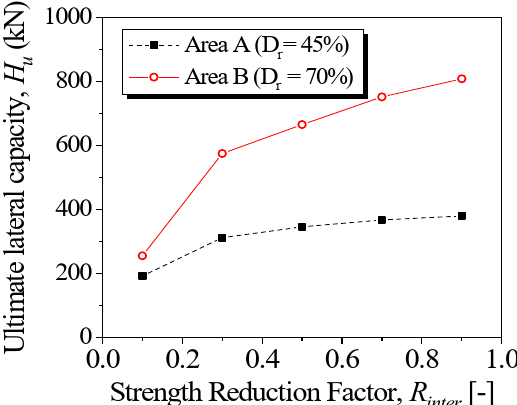
Figure 12. Change of ultimate lateral capacity of CFA piles with interface property.